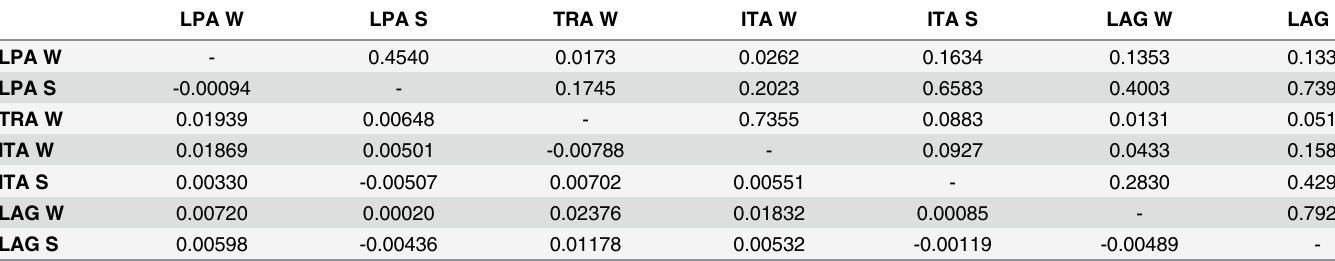
Table 5. Pairwise F ST values (below diagonal) and p -values (above diagonal) between locations, considering seasons ( α <